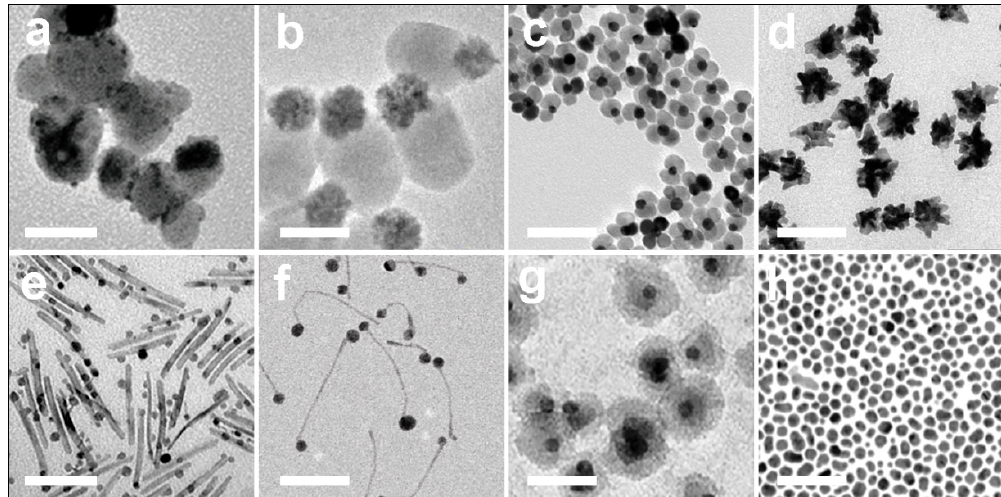
Figure 4. TEM images of heterodimers with different interfacial morphologies. Random-decorated Fe 2 O 3 -Pd heterodimers, scale bar: 30 nm, reproduced with permission from [32], copyright (2015), Royal Society of Chemistry ( a ), Janus Fe 3 O 4 -antibody dye heterodimers, scale bar: 100 nm, with permission from [143], copyright (2018) Elsevier ( b ), Flower-shaped MnO-Au heterodimers, scale bar: 50 nm, with permission from [121], copyright (2014) American Chemical Society ( c ), Star-shaped FeO x -Au heterodimers, scale bar: 100 nm [107], published by The Royal Society of Chemistry ( d ), Rod-shaped Fe 2 O 3 -TiO 2 heterodimers, scale bar: 200 nm, with permission from [144], copyright (2009) Royal Society of Chemistry ( e ), Dumbbell-shaped FePt-Au heterodimers, scale bar: 30 nm, with permission from [90], copyright (2011) Spiringer Nature ( f ), Mosaic Fe 3 O 4 -Au(thiol)@SiO 2 heterodimers, scale bar: 50 nm, with permission from [108], copyright (2015) Elsevier ( g ), and Core-shell Fe 3 O 4 @Au heterodimers, scale bar: 50 nm, with permission from [145], copyright (2005) American Chemical Society ( h ).